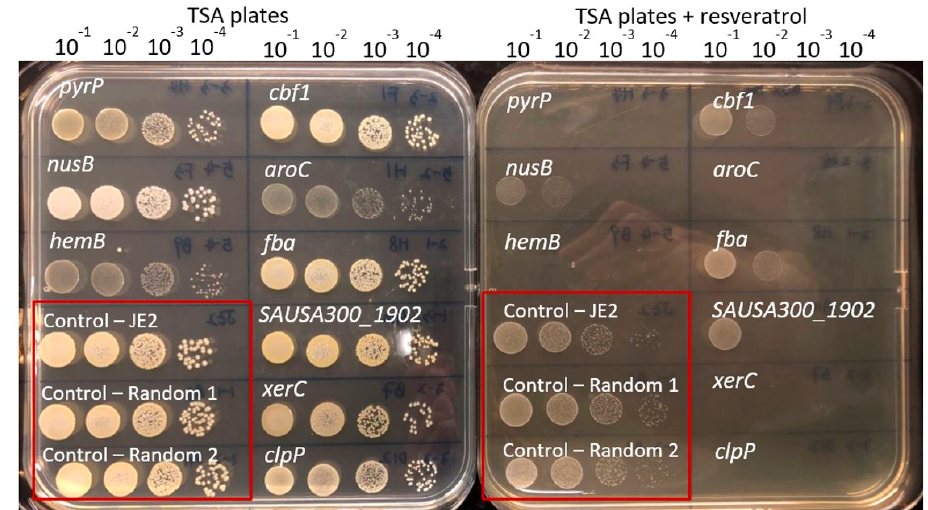
Figure 1. Confirmation of screened out mutants with increased susceptibility towards resveratrol. The growing cells were diluted 10 − 1 , 10 − 2 , 10 − 3 and 10 − 4 and fold then spotted on the tryptic soy agar (TSA) plates supplemented with resveratrol (128 µg/mL) or on drug-free TSA plates. The plates shown contain the same mutants and are provided as an example of the assay. Table 2. Screened out genes with increased susceptibility towards resveratrol.